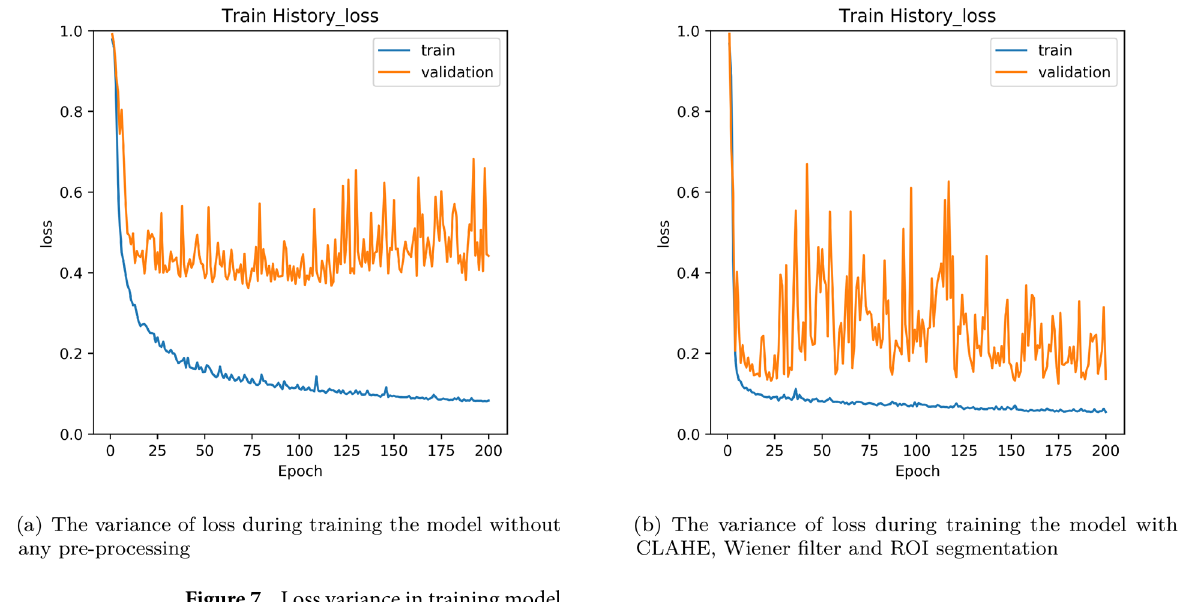
Figure 7. Loss variance in training